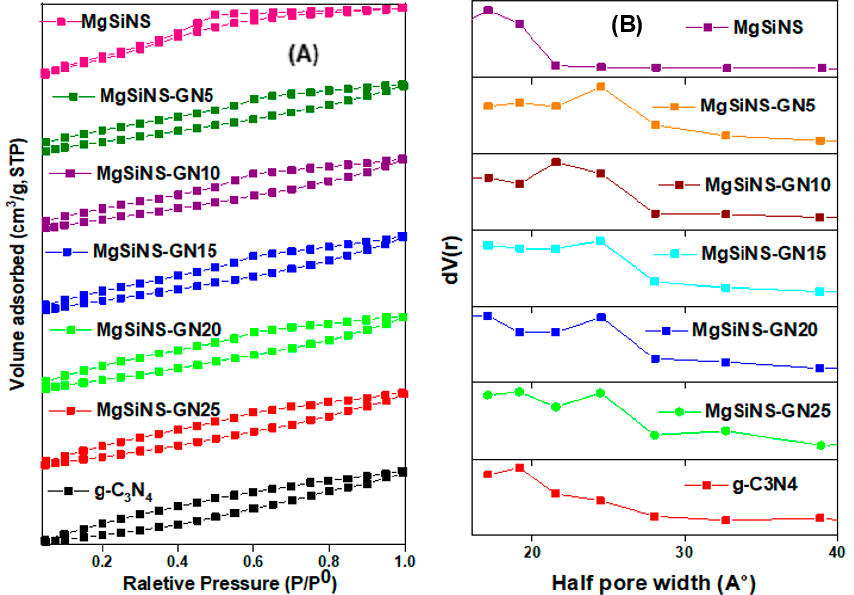
Figure 4. ( A ) N 2 adsorption–desorption isotherms and ( B ) pore size distribution patterns of the sam-